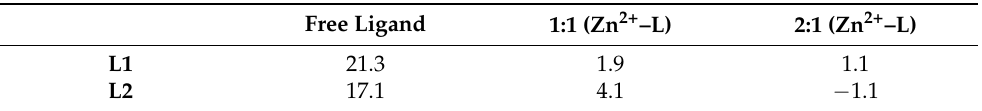
Table 2. ∆ T m values determined for the metal complexes of L1 – L2 with ctDNA (r = 0.05, NaCac 50 mM, pH 7.4).